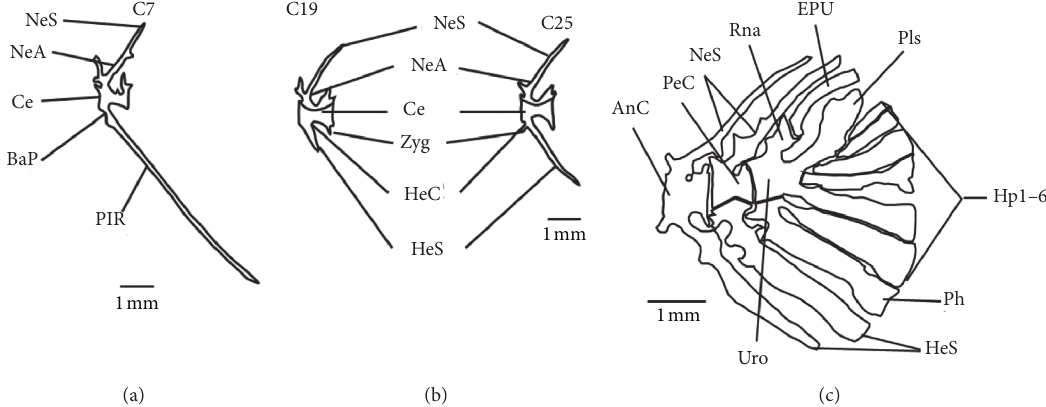
Figure 5: Lateral view of the (a) and (b) centrum 7, 19 and 25, (c) Caudal skeleton of G. rossica . Abbreviations: AnC: antepenultimate centrum; BaP: basapophysis; Ce: centrum; EPU: epural; HeC: hemal canal; HeS: hemal spine; Hp 1–6: hypural plates 1–6; NeA: neural arch; NeS: neural spine; PeC: penultimat centrum; Ph: parhypurale; PlR: pleural rib; Pls: pleurostyle; Rna: rudimentary neural arch; Uro: urostyle; Zyg: zygopophysis.